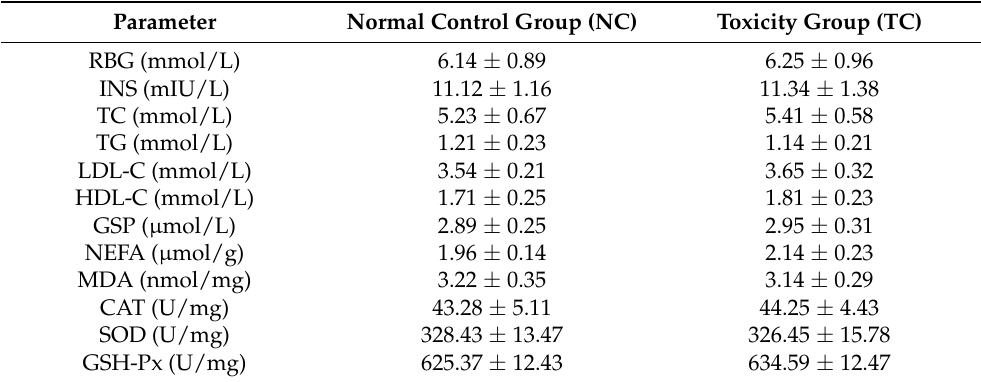
Table 8. Effects of [CrBCA 3 ] on lipid profiles, MDA levels and antioxidant enzyme activities of normal mice (means ± SD, n = 10).